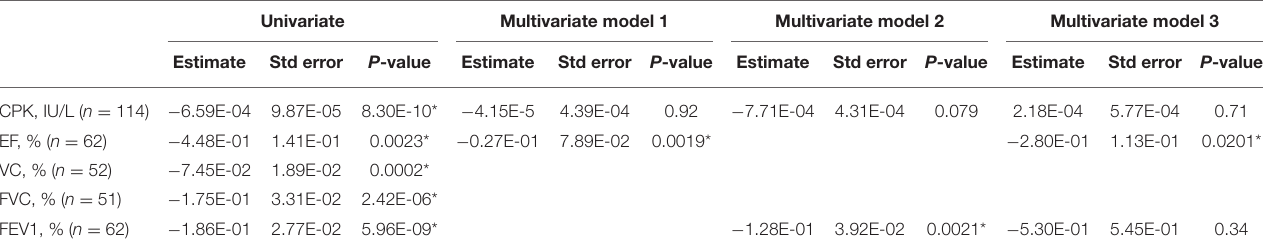
TABLE 1 | Evolution in clinical variables with ageing in LGMDR4.